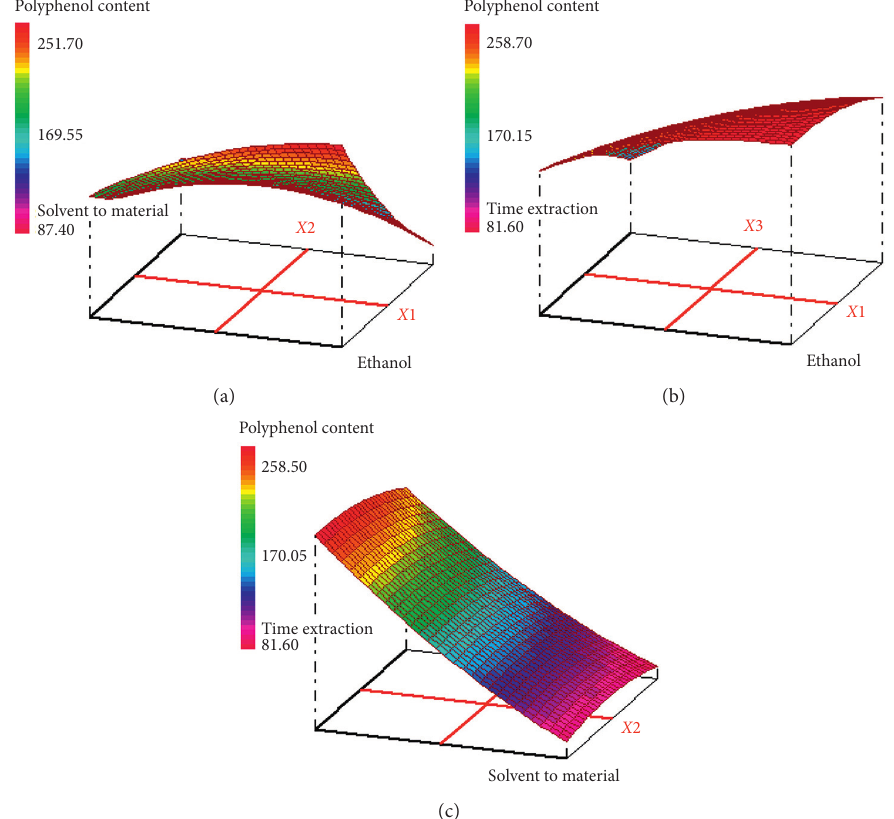
Figure 4: Response surface for the effect of independent variables on polyphenol content in hydroethanolic extract. (a) Response surface graph showing interaction between solvent-to-material ratio ( X 2) and ethanol concentration ( X 1); (b) response surface graph showing interaction between extraction time ( X 3) and solvent-to-material ratio ( X 2); (c) response surface graph showing interaction between extraction time ( X 3) and ethanol concentration ( X